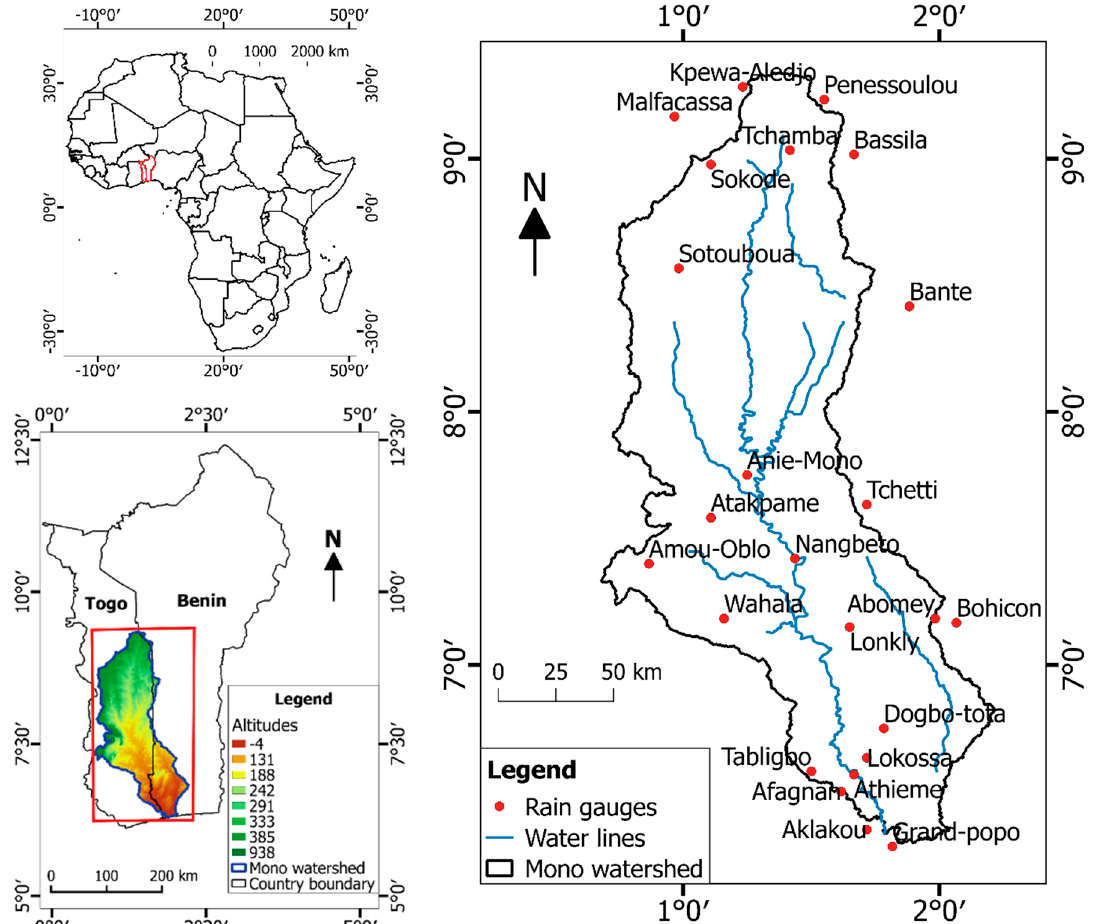
Figure 1. Location of Mono watershed and considered rain gauges.